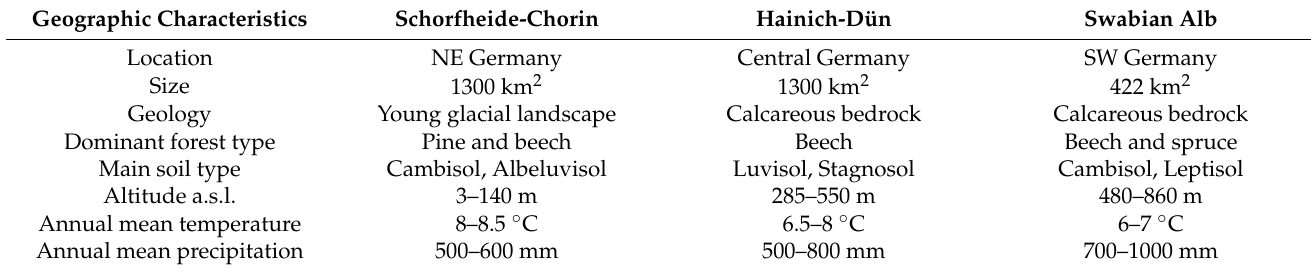
Table 1. Characteristics of the three study sites, modified from